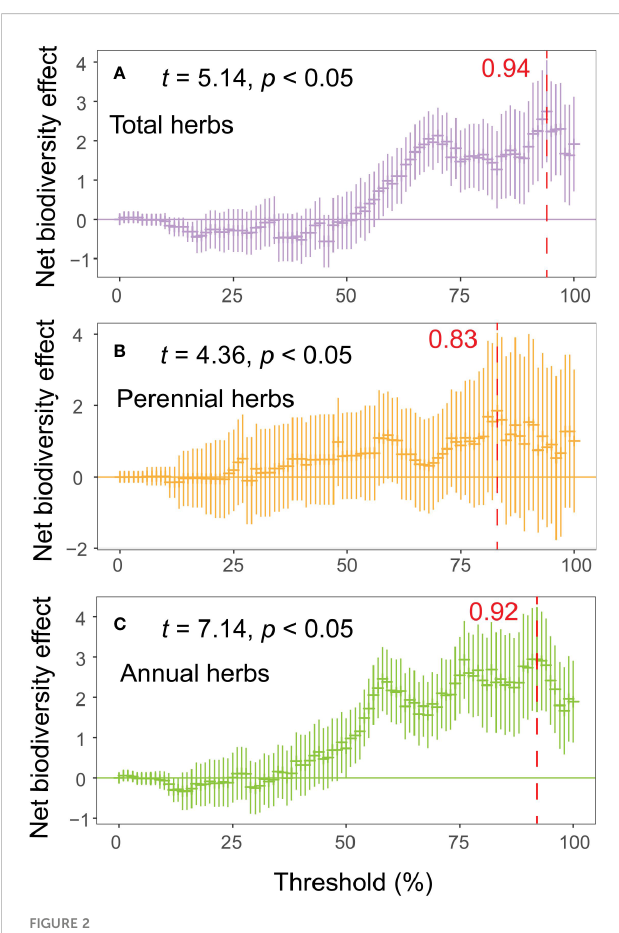
FIGURE 2 Net effect of biodiversity attributes multifunctionality. The net effect is calculated as the sum of the standardized regression coef fi cients for all biodiversity indicators selected in the model selection process ( A , total herbs; B , perennial herbs; C , annuals